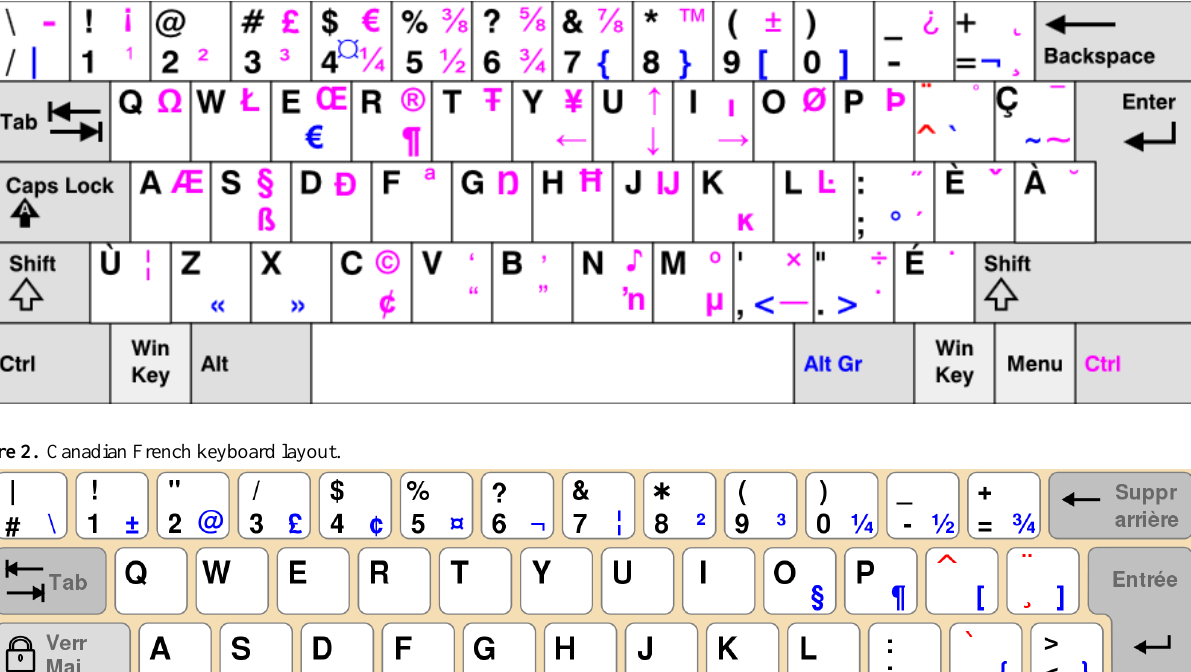
Figure 1. Canadian multilingual standard keyboard layout.